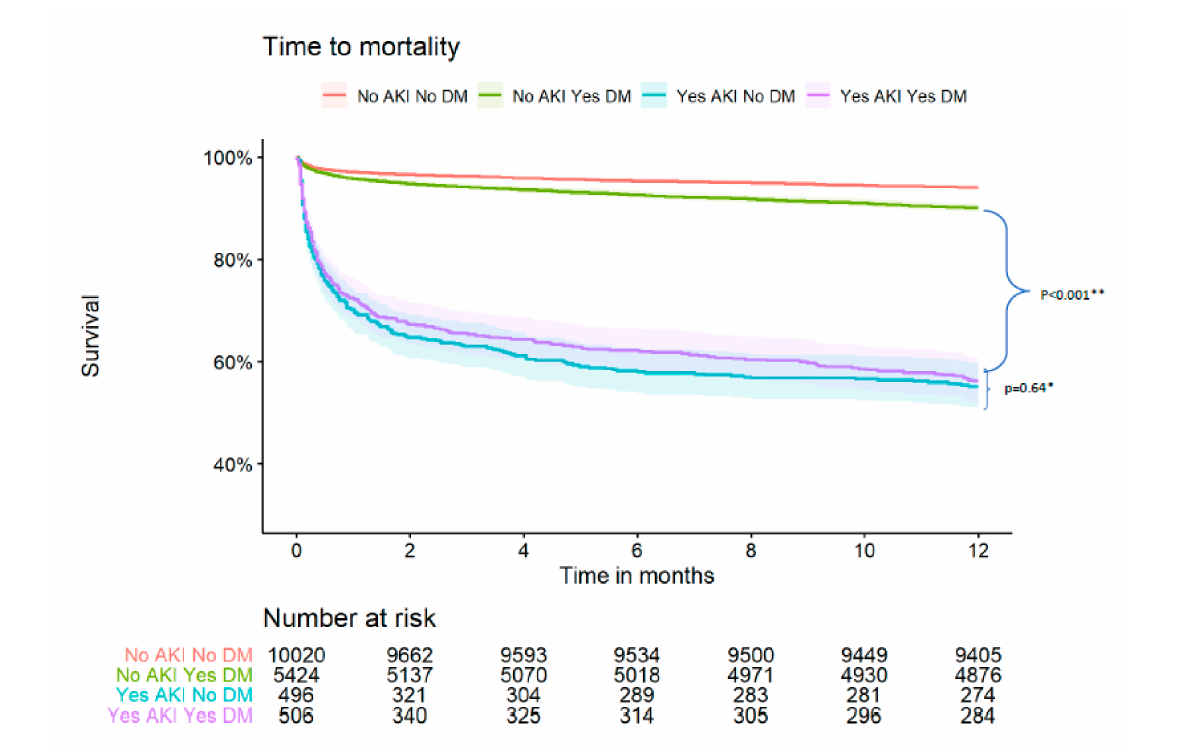
Figure 1. Kaplan Meier survival curve by DM status and AKI. * p for comparison between the following groups: AKI_ DM vs. AKI_no-DM (comparison between diabetic patients with AKI vs. non-diabetic patients that developed AKI). ** p for comparison between the following groups: AKI_DM vs. no-AKI_DM (comparison between diabetic patients with AKI vs. diabetic patients that did not develop